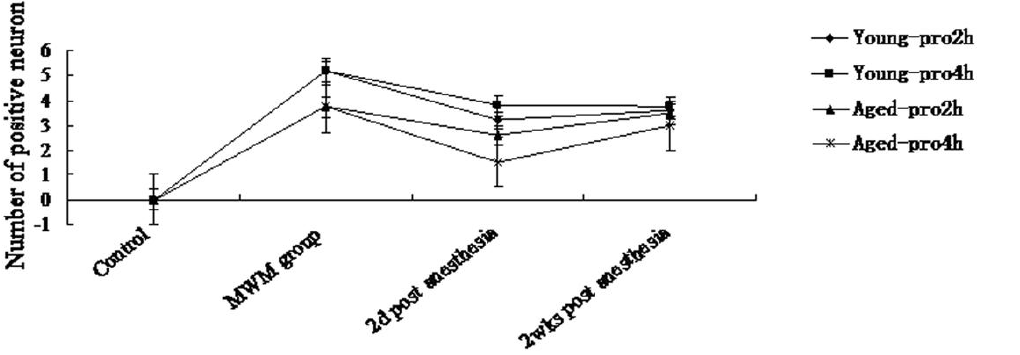
FIGURE 5 - Effect of propofol anesthesia on the expression of PKA. No PKA were seen in the hippocampal CA1 area of both young and aged rats. In MWM groups of all rats, number of PKA positive neurons in this area was significantly increased (P < 0.05), which was not affected by propofol exposure in young rats and aged rats in group P4h/2w (P>0.05). The expression of PKA was depressed in aged rats of group P4h/2d comparing with those in MWM group (P < 0.05).